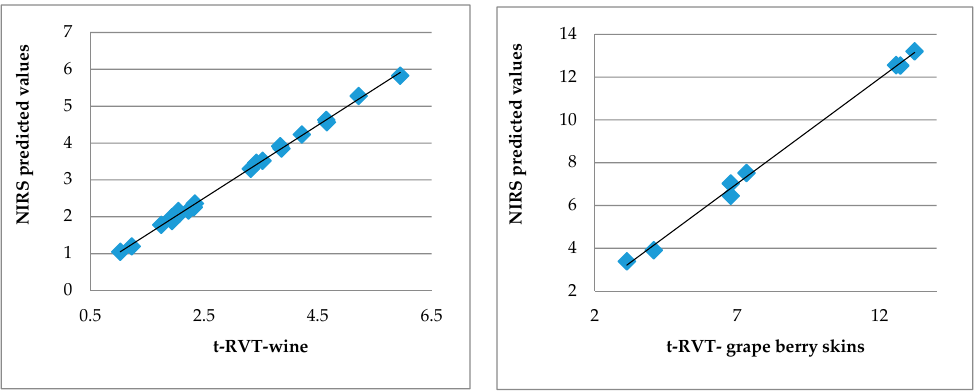
Figure 2. Scatter plots of HPLC measured and NIR spectroscopy predicted values of t-RVT in red wine